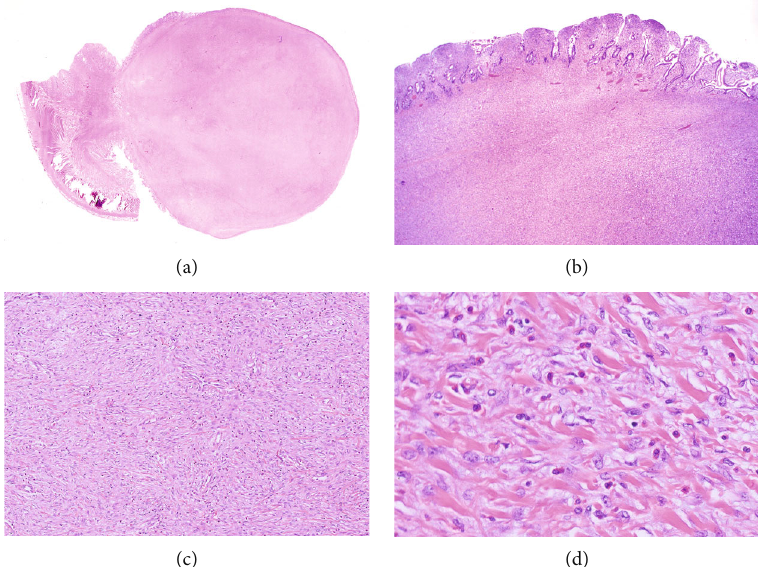
Figure 1: In fl ammatory fi broid polyp. (a, b) Low-power magni fi cation showing a predominantly submucosal nodular proliferation with some extension into mucosa comprised of bland spindle-shaped mesenchymal cells, well-vascularized with concentric distribution of in fl ammatory in fi ltrate consisting mainly of eosinophils arranged around vessels. (c, d) High-power magni fi cation showing bland spindle cells, small vessels, and eosinophil-rich mixed in fl ammatory in fi ltrate. (Hematoxylin and eosin stain: (a) original magni fi cation × 2; (b) original magni fi cation × 10; (c) original magni fi cation × 20; and (d) original magni fi cation ×